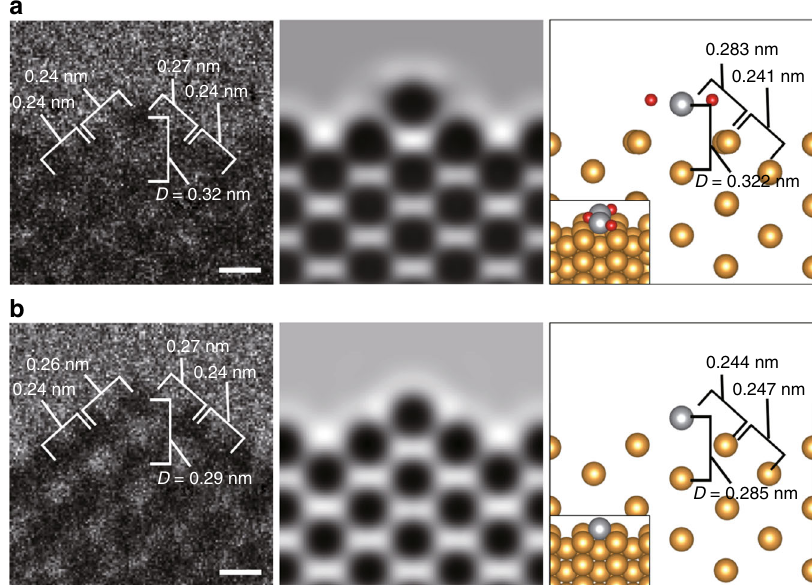
Fig. 3 Au – AgO nanofacets as the essential atomic structure in NPG. a A typical nanofacet stabilized by silver atoms located at the top atomic column with oxygen atoms in 100% O 2 (100 Pa) and b the nanofacet at the moment of instant desorption of oxygen atoms for the oxidation of CO molecules in 1 vol.% CO/air (100 Pa). From left to right in a , b are ETEM images, simulated images, and the models after ab initio calculations, respectively. Gold, silver, and red color balls represent Au, Ag, and O atoms, respectively. Quantitatively measured D in ETEM images agree well with those in the models, as seen in a , b . Distances between the inter-atomic columns near the top atomic columns are also shown. Scale bars: 0.2